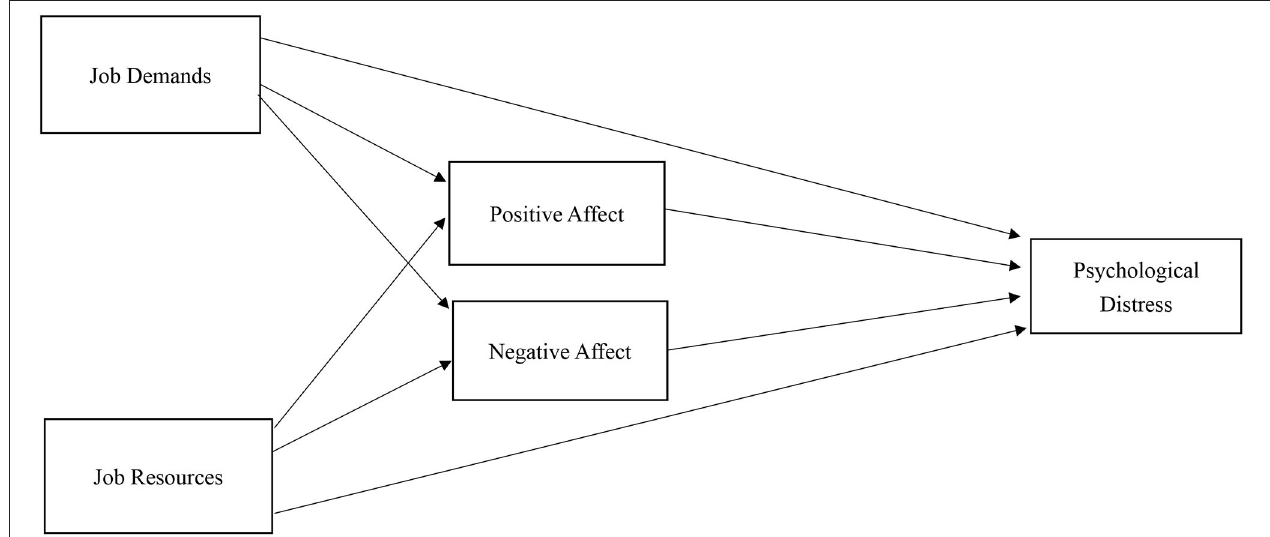
FIGURE 1 | Conceptual model of JD-R, positive affect and negative affect, and psychological